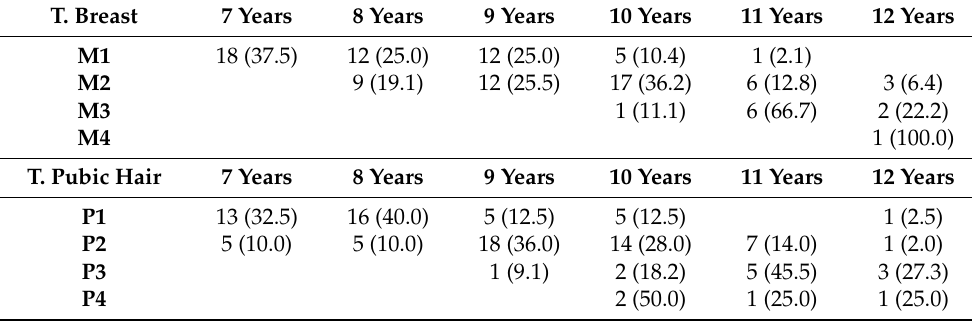
Table 1. Frequency (%) of girls according to Tanner’s sexual maturation stages and age. T. Breast